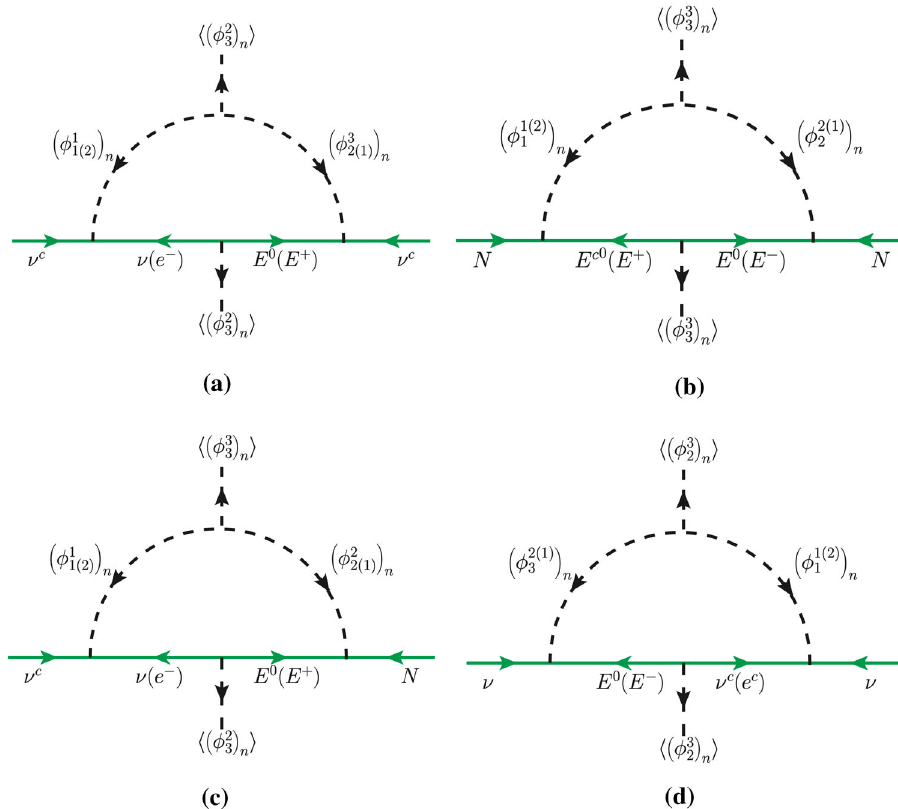
Fig. 3 Radiative one-loop neutrino mass for a ν c ν c , b N N , c ν c N and d νν . The